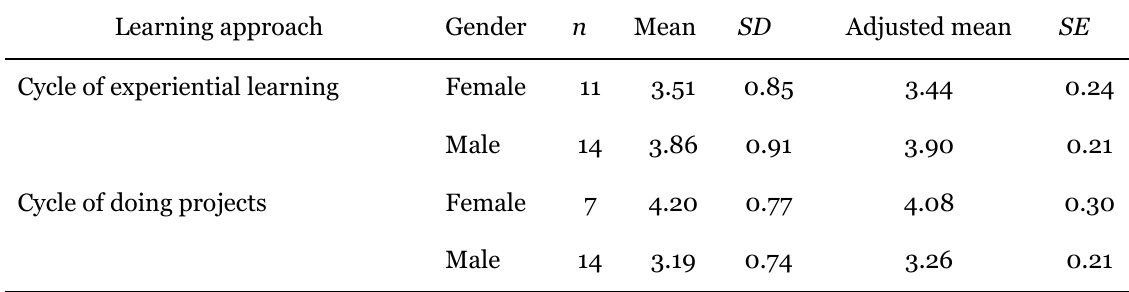
Descriptive Data after the Simple Main-Effect Analysis for Computational Thinking